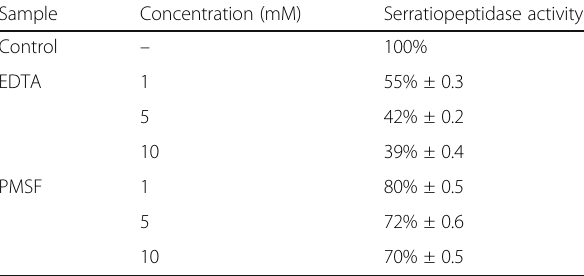
Table 2 Effect of inhibitors on serratiopeptidase activity Sample Concentration (mM) Serratiopeptidase activity Control